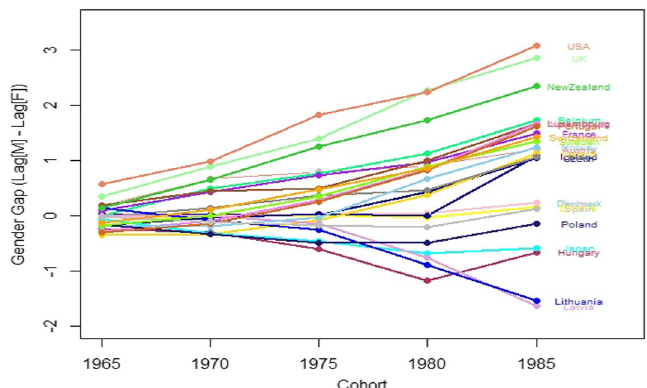
Fig. 4 Gender gap in lag for NRA over different